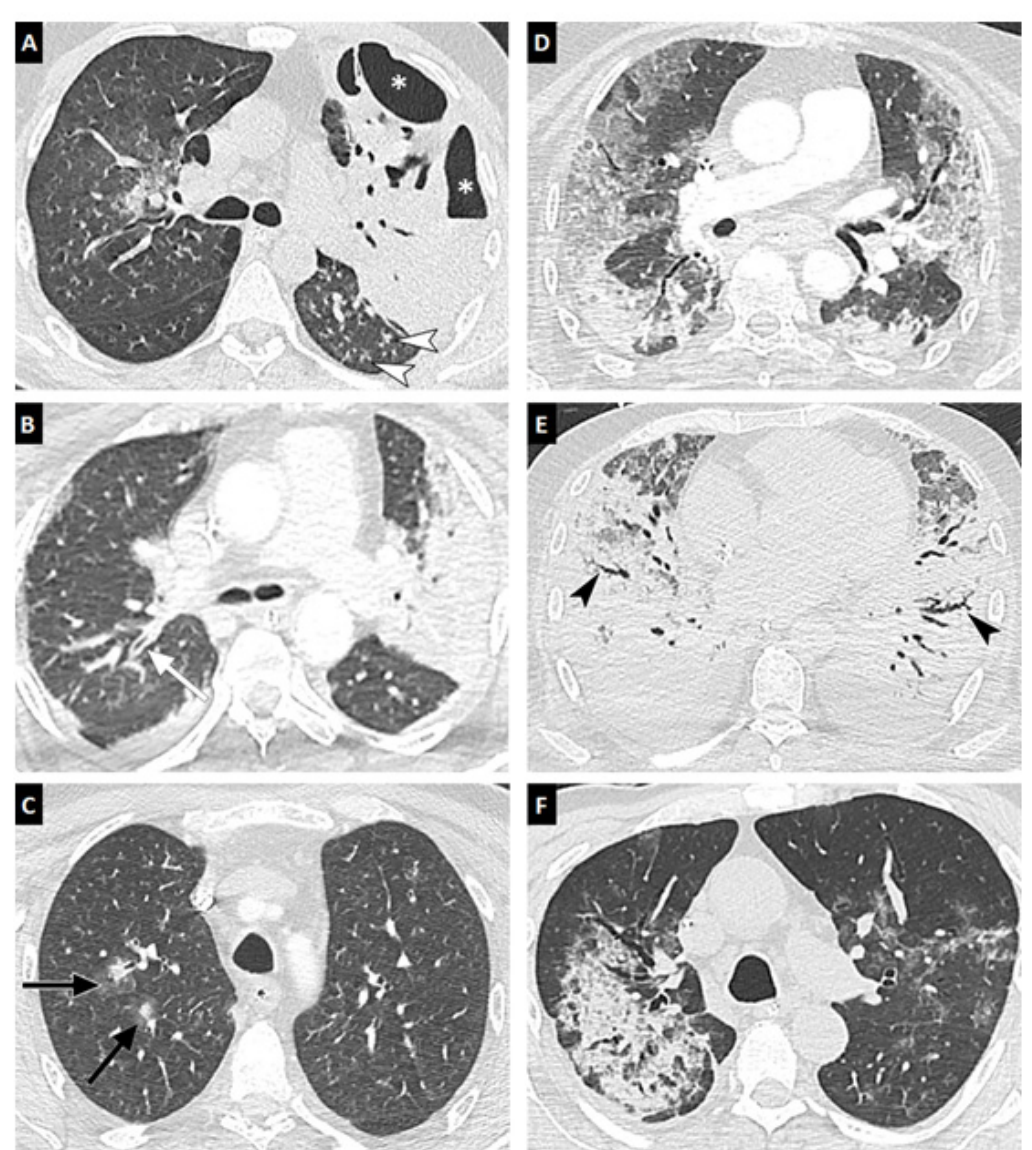
Figure 2. Chest CT-scan of LAPA and CAPA patients. Chest CT scans in the axial plane (lung window: W1600/L-500 HU) of three patients with LAPA ( A – C ) and three patients with CAPA ( D – F ). Typical CT findings in LAPA are unilateral or bilateral areas of consolidation with air bronchogram ( A , B ), cavity formation (asterisks), tree in bud (white arrowheads), bronchial wall thickening (white arrow), or occasionally nodules with halo signs ( C , black arrows). Patients with CAPA may exhibit non-specific CT findings, such as bilateral areas of ground-glass opacity and/or crazy paving ( D ), extensive consolidations areas associated with peripheral traction bronchiectasis ( E , black arrowheads), or, more rarely, unilateral consolidation areas ( F ). Despite not being very specific for a SARS COV2 infection, findings observed in ( D , E ) pictures can be seen frequently in severe COVID-19 patients.